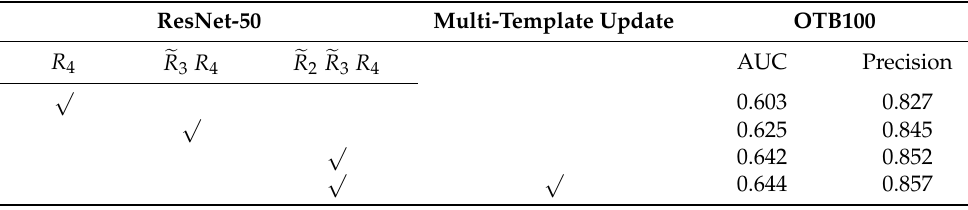
Table 4. Ablation study of the proposed tracker on OTB100. ResNet-50: Residual Network with 50 layers; OTB100: Object Tracking Benchmark 100; AUC: Area Under the